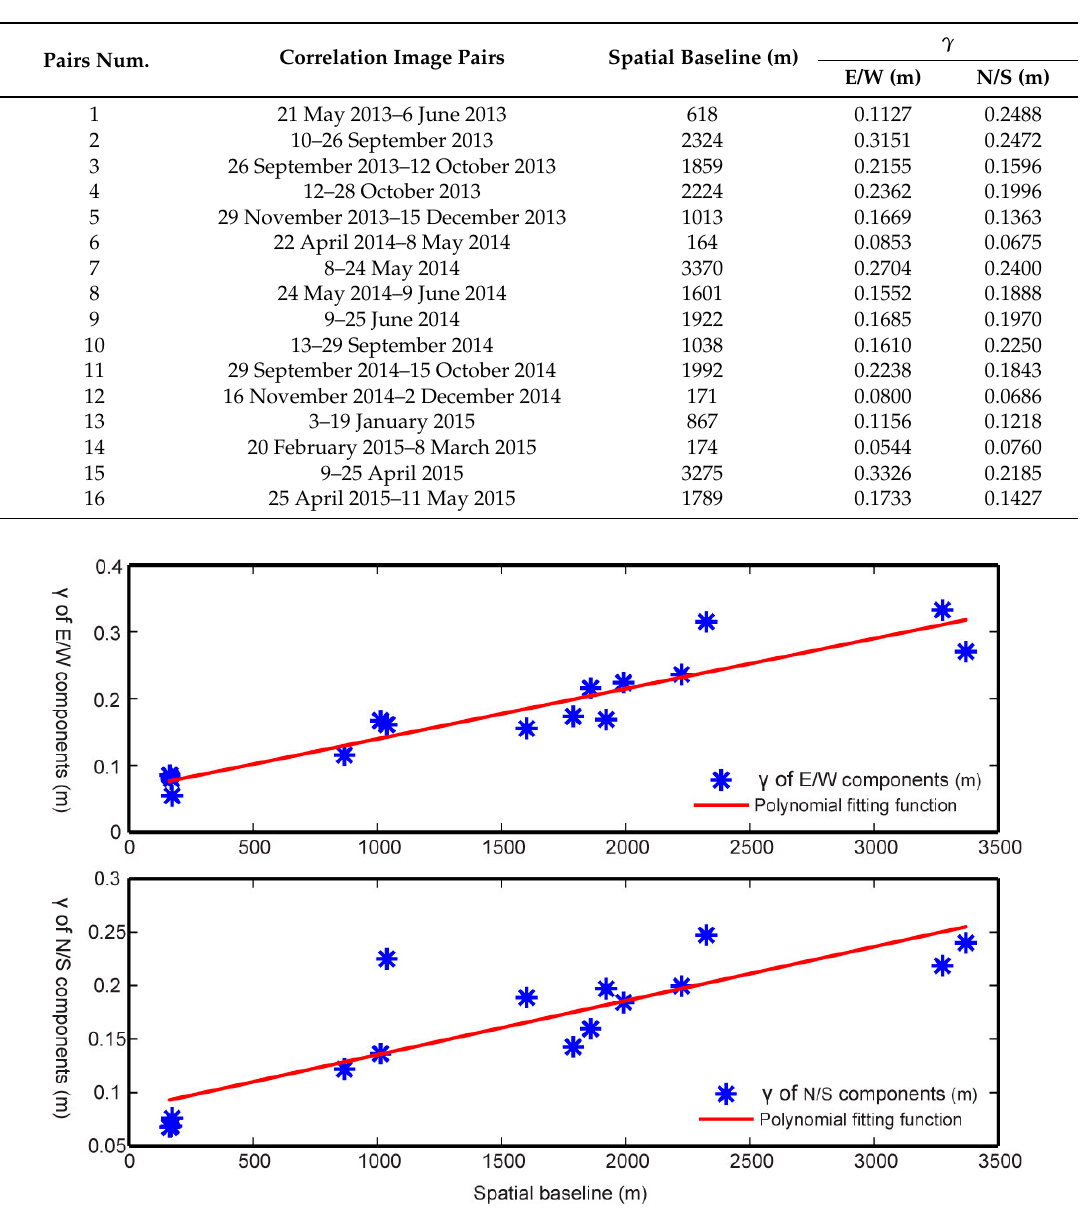
Table 1. Spatial baseline and γ of all the correlation image pairs in this study.